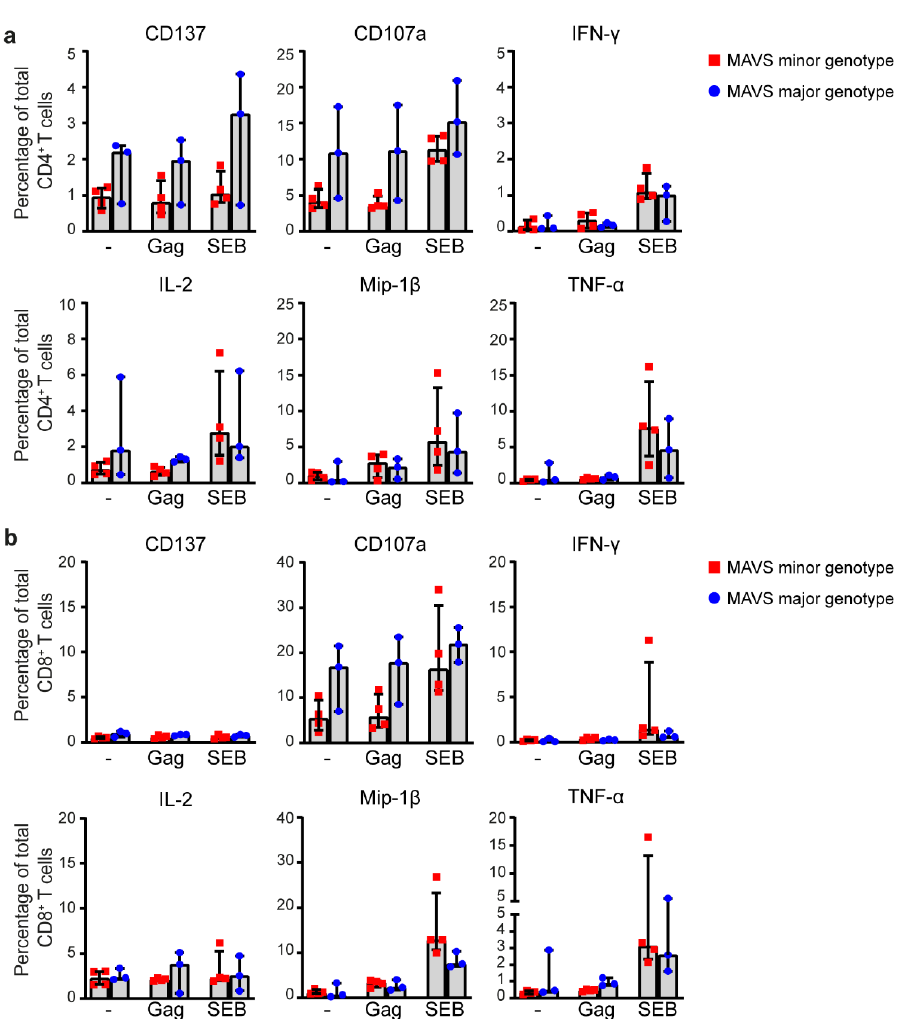
Figure 5. MAVS genetic variation does not affect intracellular cytokine levels of HIV-1-specific T cells. ( a ) PBMCs of individuals carrying a MAVS minor or MAVS major genotype obtained 2.5–3.5 years